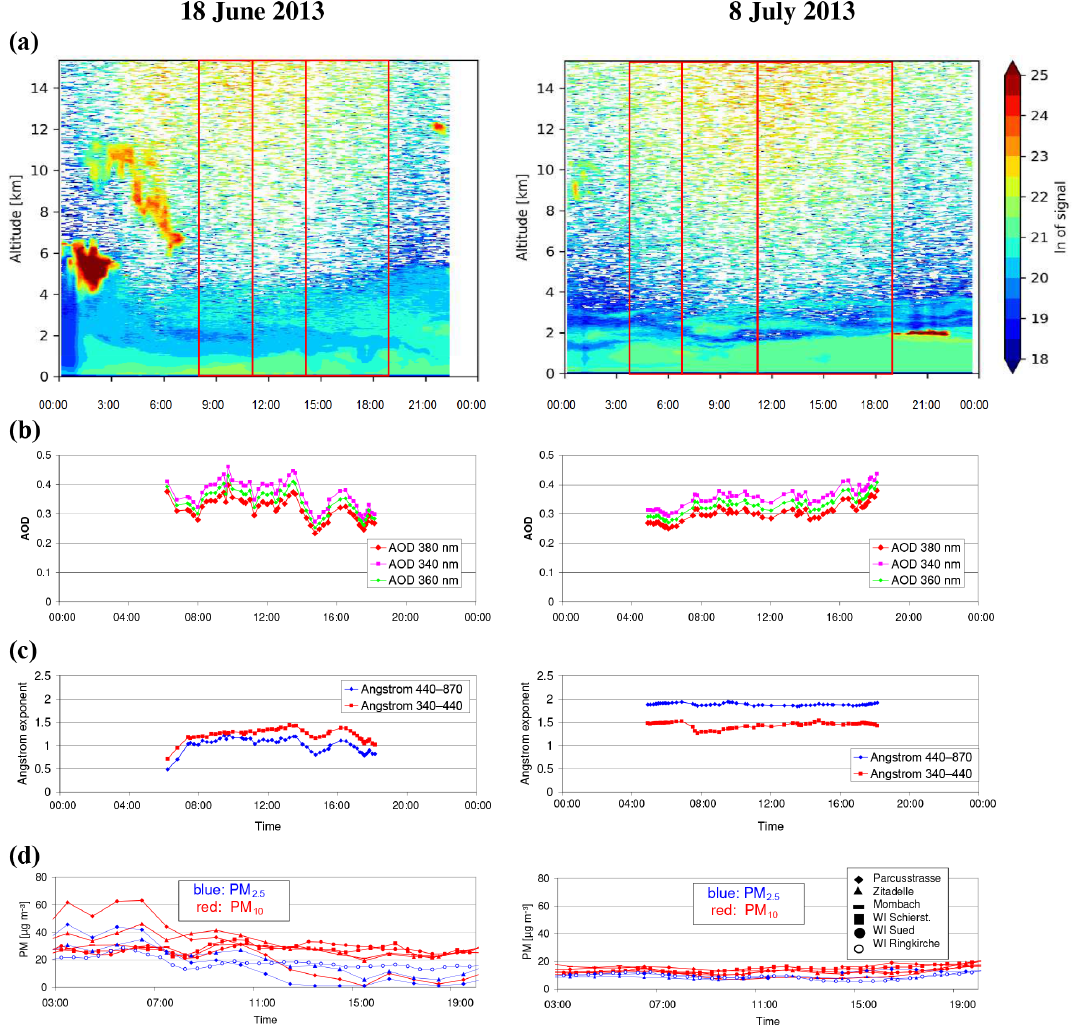
Figure 1. Various aerosol properties on the 2 selected days (left: 18 June 2013; right: 8 July 2013). (a) Aerosol backscatter profiles from ceilometer measurements. (b) AOD at 340, 360 and 380nm (360 values are interpolated from 340 and 380nm) from AERONET sun photometer measurements. (c) Ångström exponents for two wavelength pairs (340–440 and 440–870nm) from AERONET sun photometer measurements. (d) Surface in situ measurements of PM 2 . 5 and PM 10 measured at different air quality monitoring stations in Mainz and the nearby city of Wiesbaden. Table 6. Standard settings for the radiative transfer